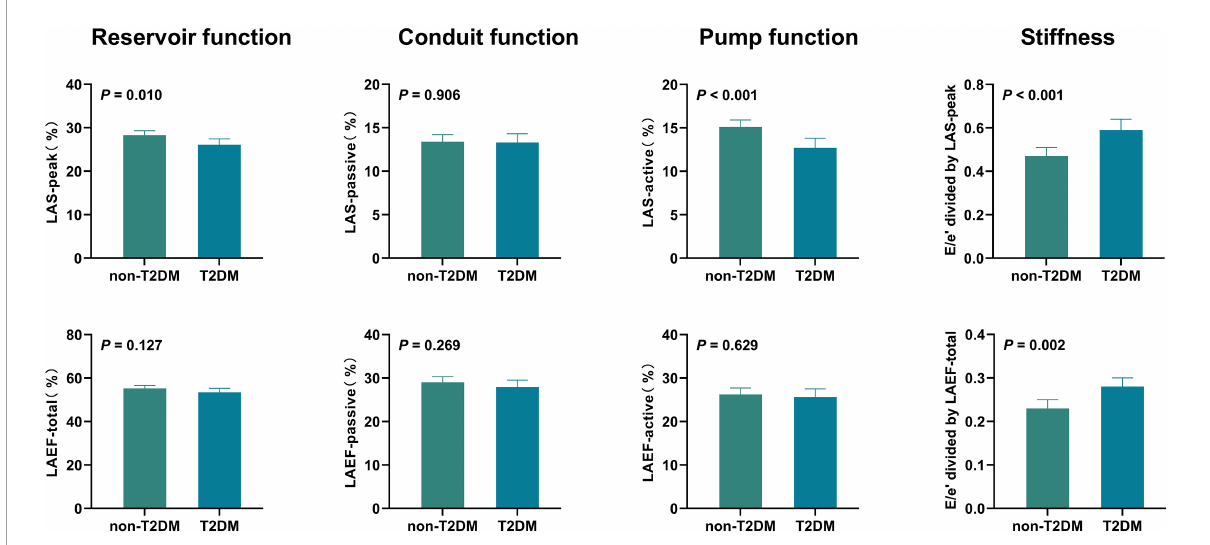
FIGURE2 Adjusted comparisons of LA function and stiffness between HFpEF patients with and without T2DM HFpEF, heart failure with preserved ejection fraction; LA, left atrial; LAS, LA strain; LAEF, LA ejection fraction; T2DM, type 2 diabetes mellitus. Adjusted for age, sex, body mass index, heart rate, systolic blood pressure, LV global longitudinal strain, and (or)